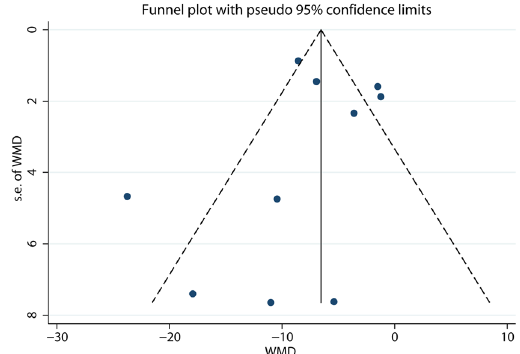
Figure 4. Funnel plot of primary outcome of included RCTs.